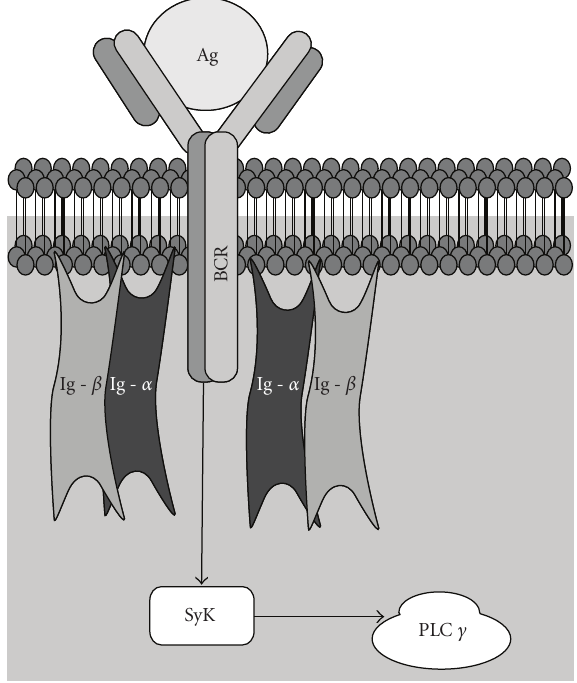
Figure 2: The Role of Syk in Antigen-Mediated Activation of the B-cell Receptor. The B-cell receptor (BCR) is composed of a ligand binding moiety that interacts with antigen (Ag) and a signaling moiety in the form of the heterodimer, Ig- α /Ig- β complex, (also known as CD79) which is held together by disulfide bridges. Each component of the Ig- α /Ig- β heterodimer complex spans the plasma membrane and also possesses a cytoplasmic tail component containing the immunoreceptor tyrosine-based activation motif (ITAM). In this example, the binding of Ag to BCR triggers phosphorylation of Syk. Activation of Syk regulates phospholipase C γ (PLC γ ) activity. PLC γ 2 was recently shown to be required for the formation, maintenance and survival of memory B cells within germinal centers